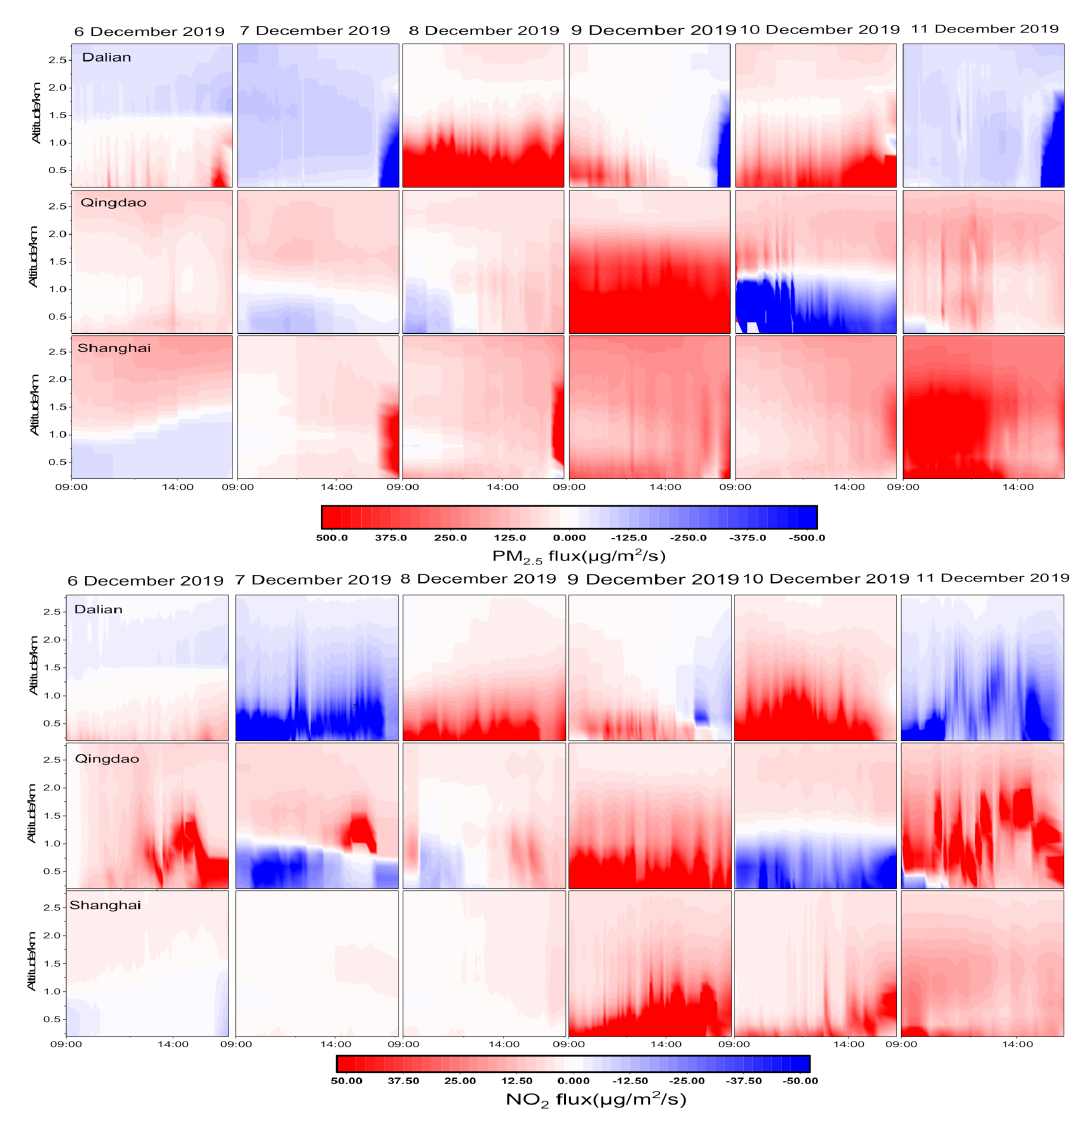
Figure 12. PM 2.5 and NO 2 flux profiles in Dalian, Qingdao, and Shanghai from 6 December 2019 to 11 December 2019. The red indicates output flux from inland to sea, and the blue indicates input flux from sea to inland.